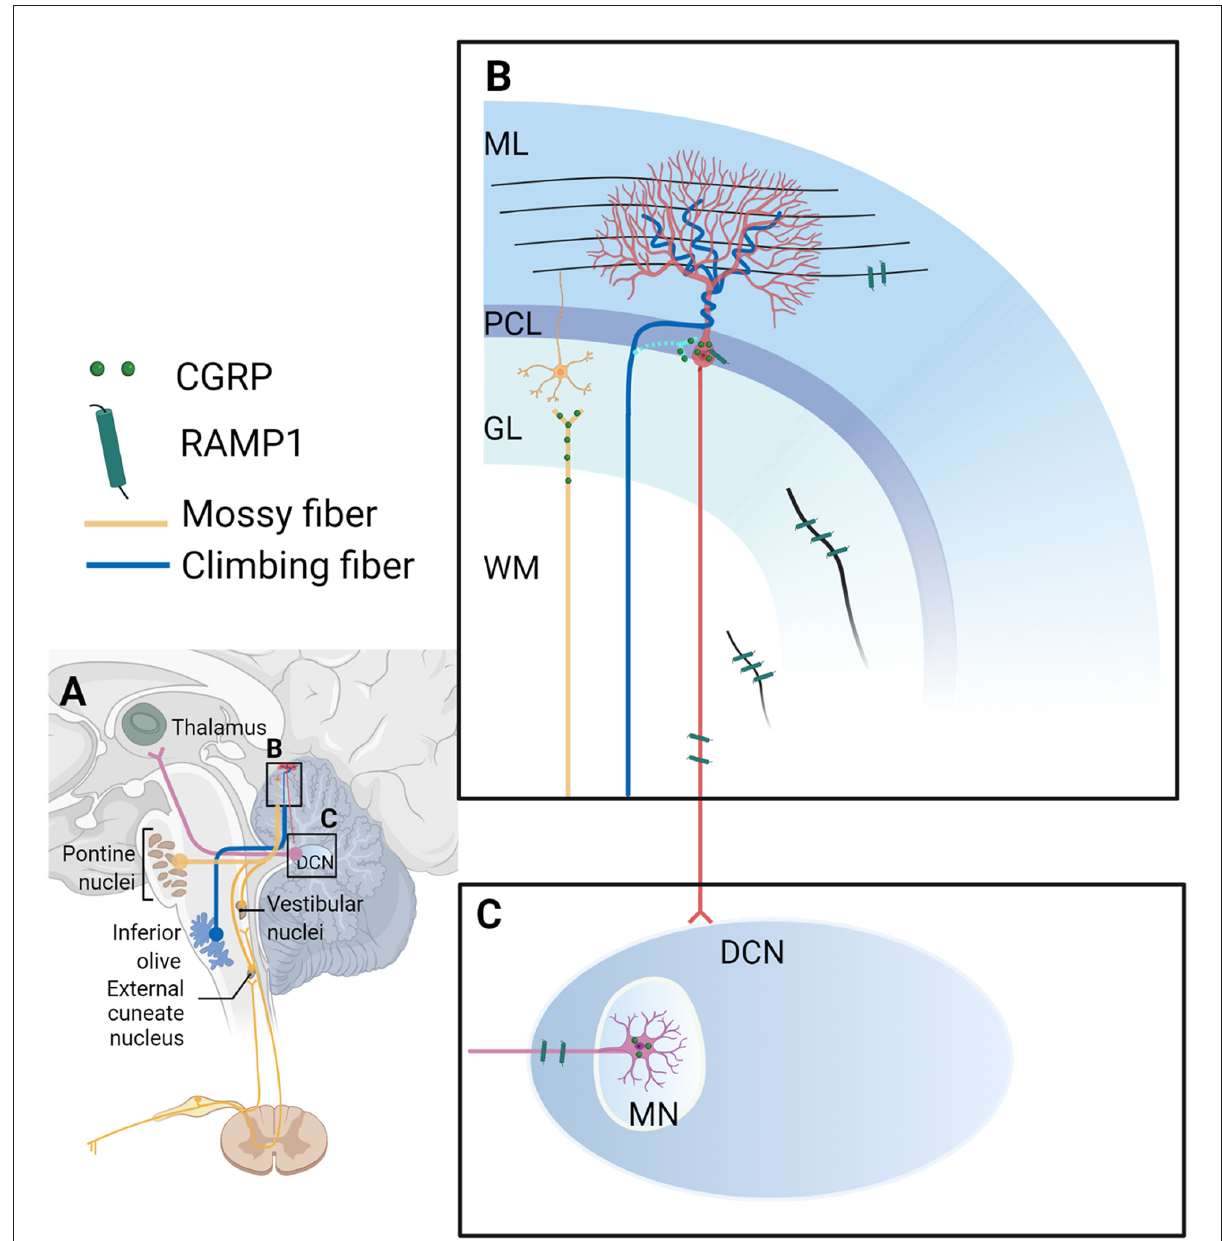
FIGURE2 Calcitonin gene-related peptide (CGRP)-positive input to the cerebellum and CGRP and RAMP1 expression in the cerebellum. (A) Overview of CGRP-positive inputs to the cerebellar cortex from the inferior olive via the climbing fiber (blue line), and the pons, vestibular nuclei, and external cuneate nucleus via climbing fibers (yellow line). The deep cerebellar nucleus projects to the thalamus (pink line). Magnified and detailed views of box B and box C are displayed in (B,C) , respectively. (B) Climbing fibers: During postnatal development, CGRP-positive climbing fiber terminals from the inferior olive converge on the cell somas of nearby Purkinje cells (light blue line; these synapses between climbing fibers and Purkinje cell bodies disappear but synaptic contacts between climbing fibers and Purkinje cell dendrites are established in adulthood (dark blue line; Hashimoto and Kano, 2005; Hashimoto et al., 2009). Mossy fibers : In adult brains, CGRP-positive mossy fibers were shown to originate from the brainstem precerebellar nuclei (lateral reticular nucleus, external cuneate nucleus, inferior vestibular nucleus, and basilar pons; yellow line). Purkinje cells : In rats, CGRP is distributed in the cytoplasm of the Purkinje cell bodies intracellularly as grains, not found in the dendrites/axons nor other cells (red lines and cell). RAMP1 : In the rat cerebellum, RAMP1 was found on the surface of the Purkinje cell bodies and their processes, and discovered as fibers in the molecular layer, granular layer (the black line in the GL), and white matter (the black line in the WM). Yellow cell: the granular cell; red cell: the Purkinje cell. (C) In the MN of the rat brain, CGRP is localized in the cell somas of large neurons as grains. RAMP1 was also found as processes, but not in the cell somas in the MN. It is unclear where CGRP-expressing neurons in the MN project. CGRP, calcitonin gene-related peptide; DCN, deep cerebellar nucleus; GL, granular cell layer; ML, molecular layer; MN, medial cerebellar nucleus; MW, white matter; PCL, Purkinje cell layer; RAMP1, receptor activity-modifying protein 1. The figure was created with